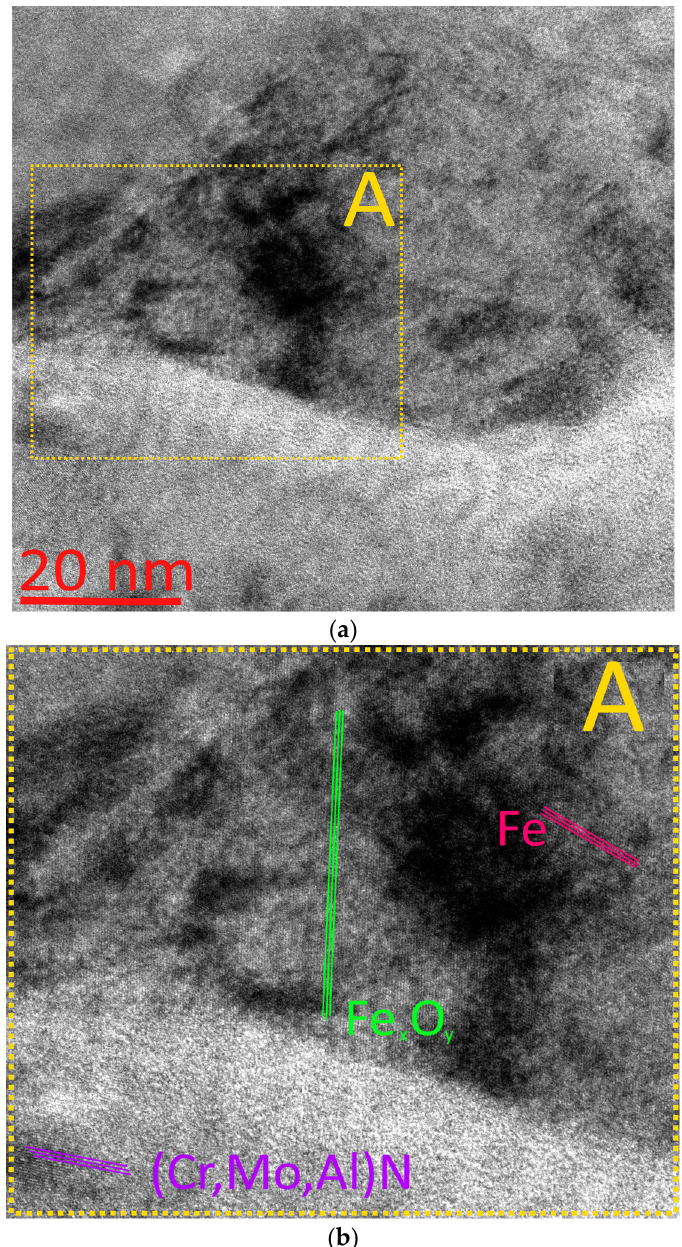
Figure 8. Study of the crystal structure of the area on the boundary between the contact of the cut material layer and the coating. ( a ) General view of the studied coverage area; ( b ) Identification of grains: iron, iron oxide and cubic structure of the coating.